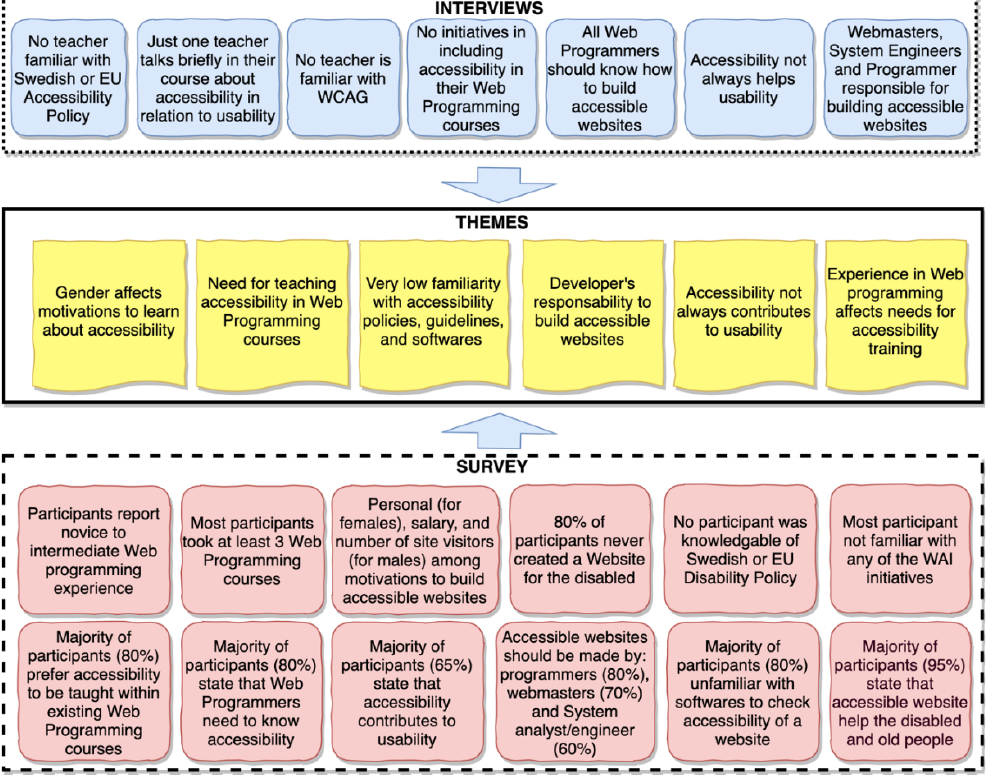
Figure 1. Affinity diagram of the process of developing emerging themes from interviews and survey Figure 1. A ffi nity diagram of the process of developing emerging themes from interviews and responses. survey